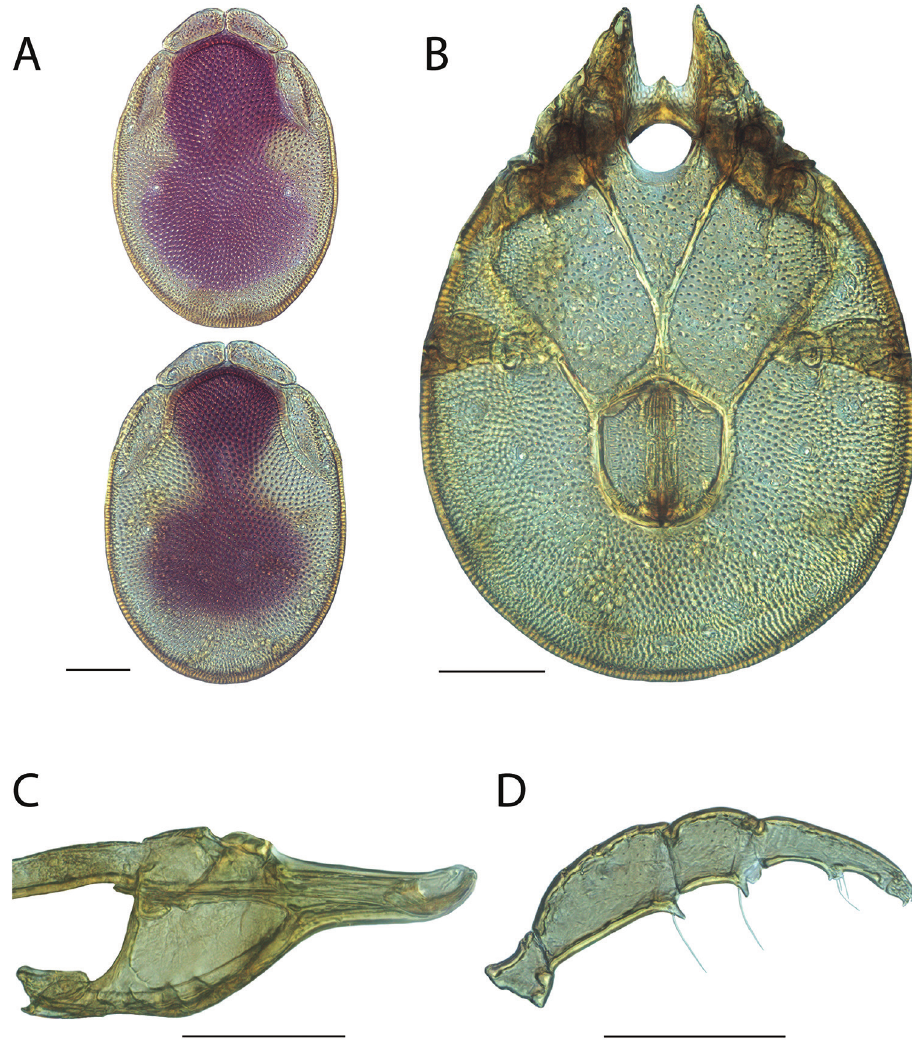
Figure 77. Torrenticola feminellai sp. n. male: A dorsal plates B venter (legs removed) C subcapitulum D pedipalp (setae not accurately depicted). Scale = 100